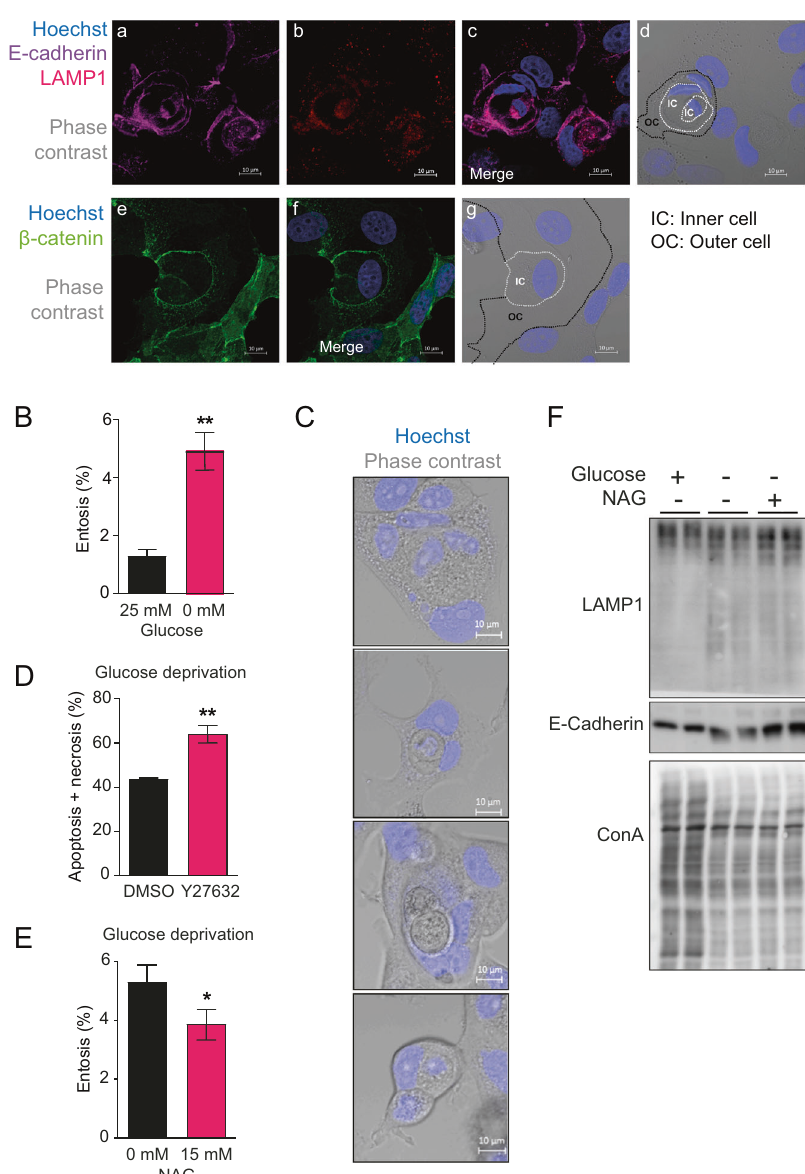
Fig. 1 Entosis in MCF7 breast epithelial cells after glucose deprivation. A Confocal images of entosis events in wild-type MCF7 cells grown for 72 h in 0 mM glucose media. Cells were stained with antibodies against E-cadherin (violet), LAMP1 (red) and β -catenin (green). Nuclei were stained with Hoechst (blue). B Percentage of entosis in wild-type MCF7 cells after manual counting of cell-in-cell bodies representing entotic/ engulfed cells at the 72 h time point at 0 mM glucose. Entotic cells were determined using confocal imaging (Two-tailed t -test; n = 5). C Representative confocal photographs of engulfed cell-in-cell bodies identi fi ed as entotic bodies for manual counting. Nuclei were stained with Hoechst (blue). D Percentage of apoptotic + necrotic cells in wild-type MCF7 cells after 72 h of glucose deprivation in the presence of ROCKi (Y27632, 10 µM) or vehicle (DMSO). Cells were analyzed by fl ow cytometry using Annexin V-APC and SYTOX ™ Green Nucleic Acid Stain (Two-tailed t -test; n = 3). E Percentage of entotitic cells observed in wild-type MCF7 cells at the 72 h time point of growth in 0 mM glucose media in the presence or absence of NAG (15 mM). Entotic cells were determined using confocal imaging and manually counted (Two-tailed t - test; n = 3). F Western blot for human LAMP1, E-cadherin and Concanavalin A after culturing the cells at 0 mM glucose, or 0 mM glucose in the presence of NAG (15 bands for speci fi c membrane protein markers such as LAMP1 was could be measured under the microscope (Fig. 2A and represen- increased in the presence of tunicamycin (Supplementary Fig. 1B), tative images in Fig. 2B). Consistently, inhibition of entosis using all-in-all consistent with defects in glycosylation resulting in the ROCKi increased the population of apoptotic + necrotic cells appearance of partially glycosylated peptides. (Fig. 2C). As either glucose deprivation or tunicamycin/NGI-1 induced ER- Total protein glycosylation was reduced upon tunicamycin or stress, we next evaluated whether entosis was a consequence of ER- NGI-1 treatment as determined by Concanavalin A western blot stress signaling and independent of protein glycosylation defects, by (Fig. 2D). Also, the relative amount of intermediate, smeared